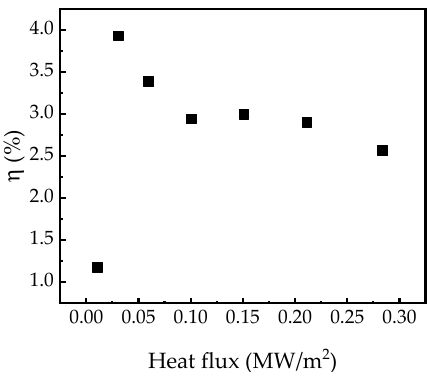
Figure 1. Thermal rectification coefficient as a function of heat flux in the Si/PA nanowire [25].